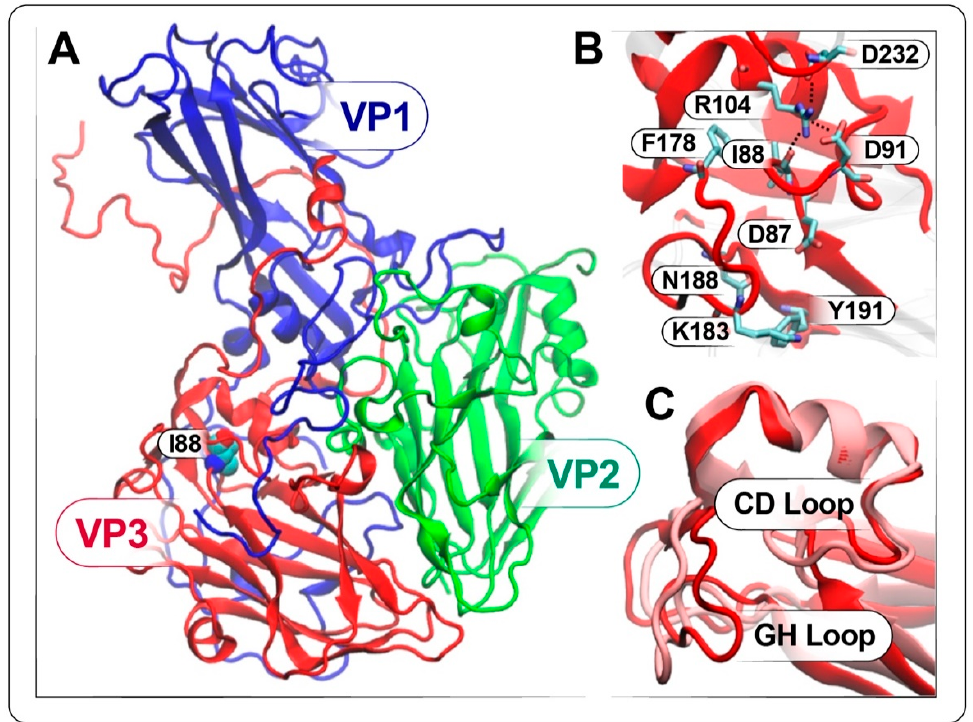
Figure 9. Comparison of the simulated VP3-I88 and VP3-I88V structures. ( A ) VP1 (blue), VP2 (green) and VP3 (red) of EV-D68 are represented in new cartoon format. I88 is represented in van der Waals sphere format. The inset reports on the position of I88 within the pentamer with respect to VP1, VP2 and VP3. ( B ) Representation of the VP3 residues within 12 Å of I88 in new cartoon format. Residues interacting with I88 or showing relevant changes between VP3-I88 and VP3-I88V simulated structures are displayed in licorice format. ( C ) Comparison between the VP3-I88 (red) and VP3-I88V (pink) simulated structures extracted from the last frame of the simulations. In all panels, residues are colored according to the atoms: oxygen in red, carbon in cyan, nitrogen in blue; hydrogens are omitted for clarity.